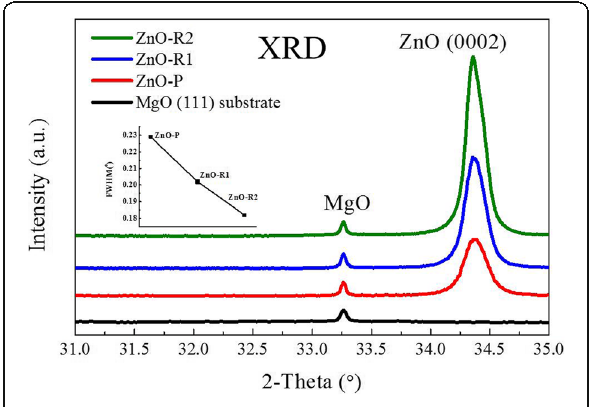
Fig. 2 XRD results. XRD patterns of the MgO(111) substrate and films with particle- or ridge-like morphologies. The inset shows the FWHMs of the ZnO(0002) peak for these three